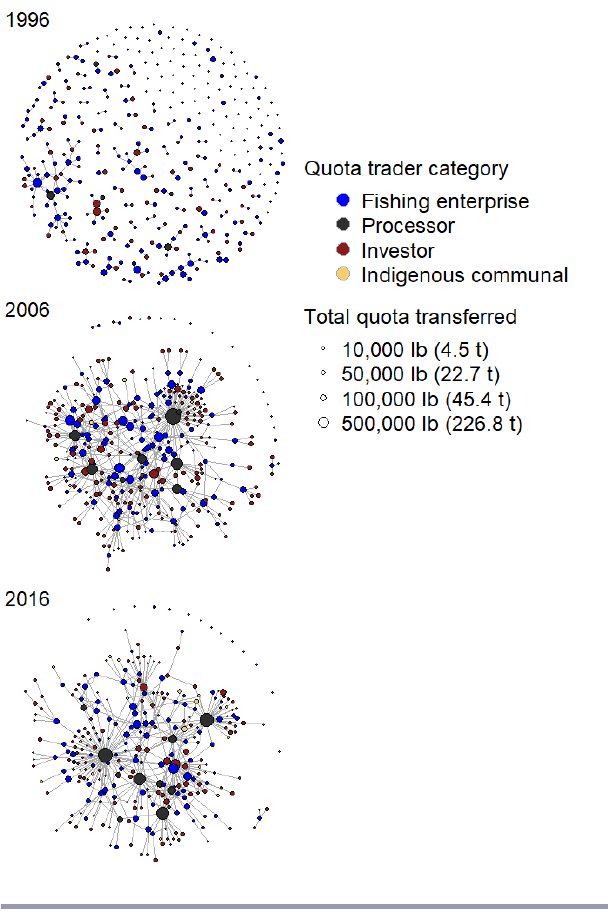
Fig. 3 . The quota trading network in the British Columbia halibut fishery in 1996, 2006, and 2016, as characterized by temporary quota transactions between quota